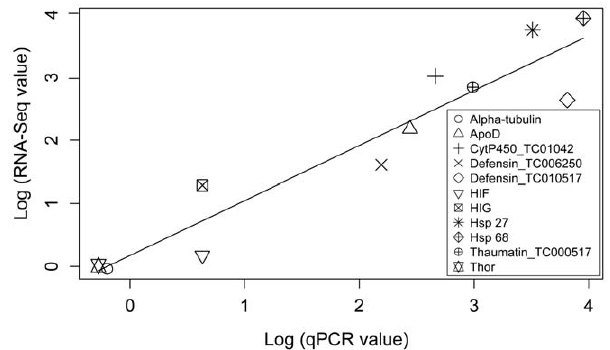
Figure 2. Correlation of gene expression levels of selected genes by both our recent qRT-PCR [ 12 ] and present RNASeq approach. The determined values of the expression levels of selected genes are shown as logN values. The values of both experiments were comparable and correlated with statistical significance (Pearson correlation, P,